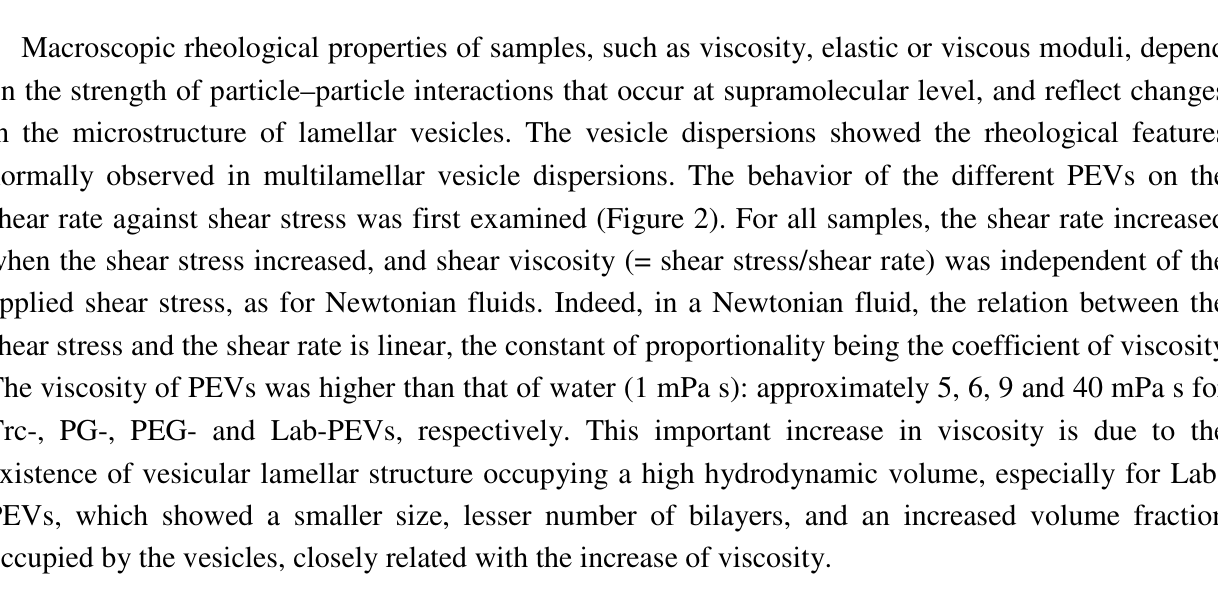
Figure 2. Linear scale plots of shear rate vs shear stress for QUE-loaded